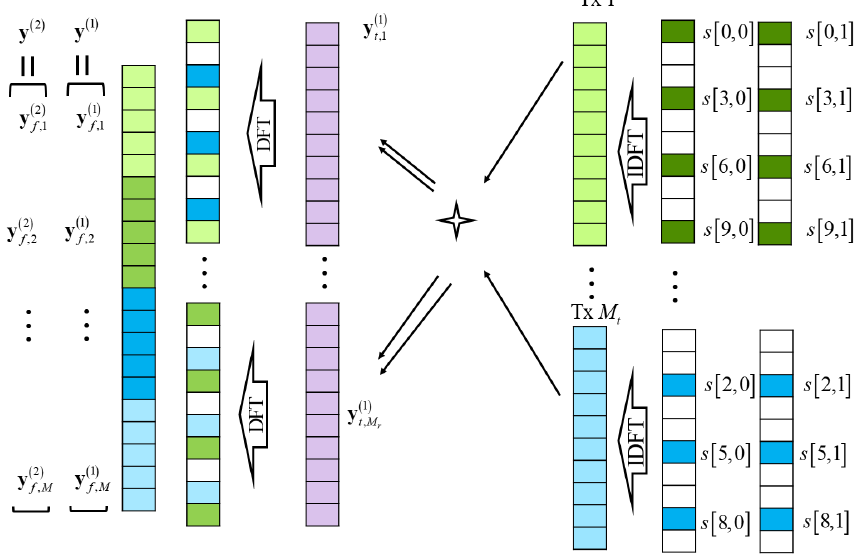
Figure 2. Radar signal process in MIMO OFDM RadCom.